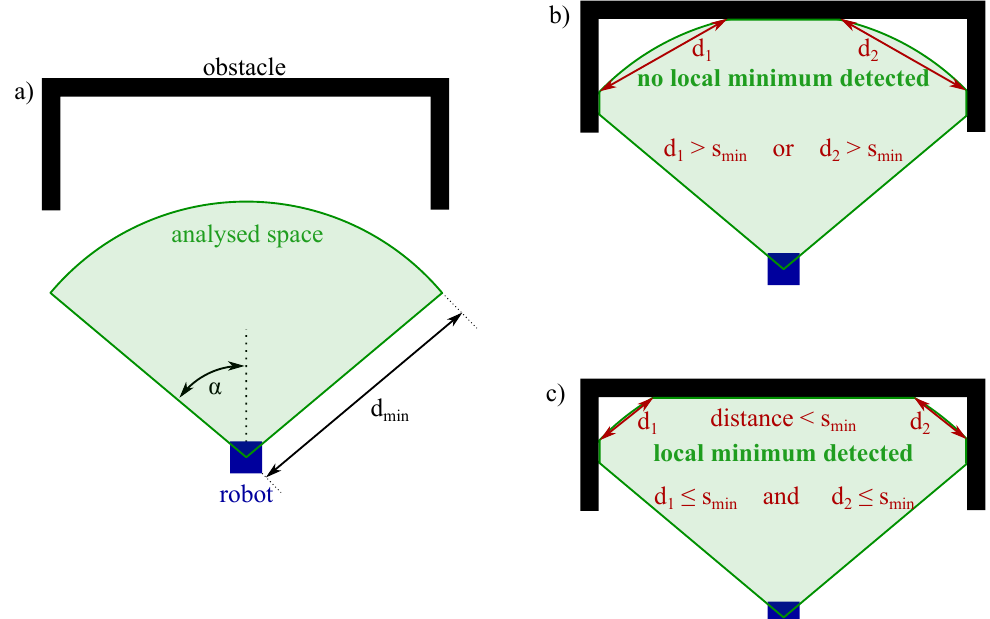
Figure 3. Detection of the local minimum: ( a ) parameters of analysed space visualization, ( b ) no local minimum detected, and ( c ) local minimum